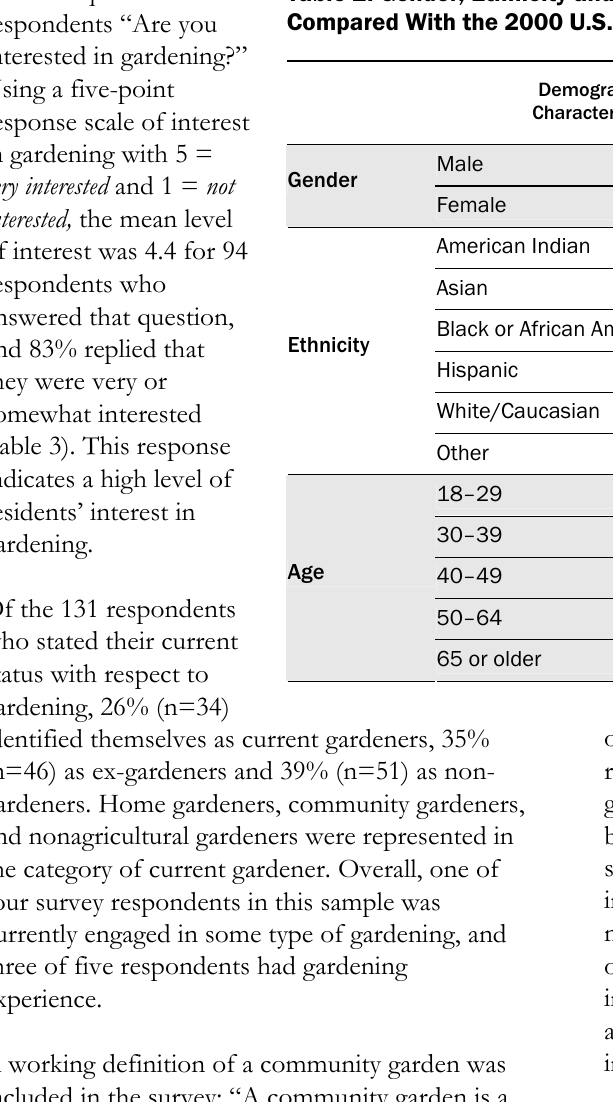
Table 3: Level of Interest in Gardening (N=94)